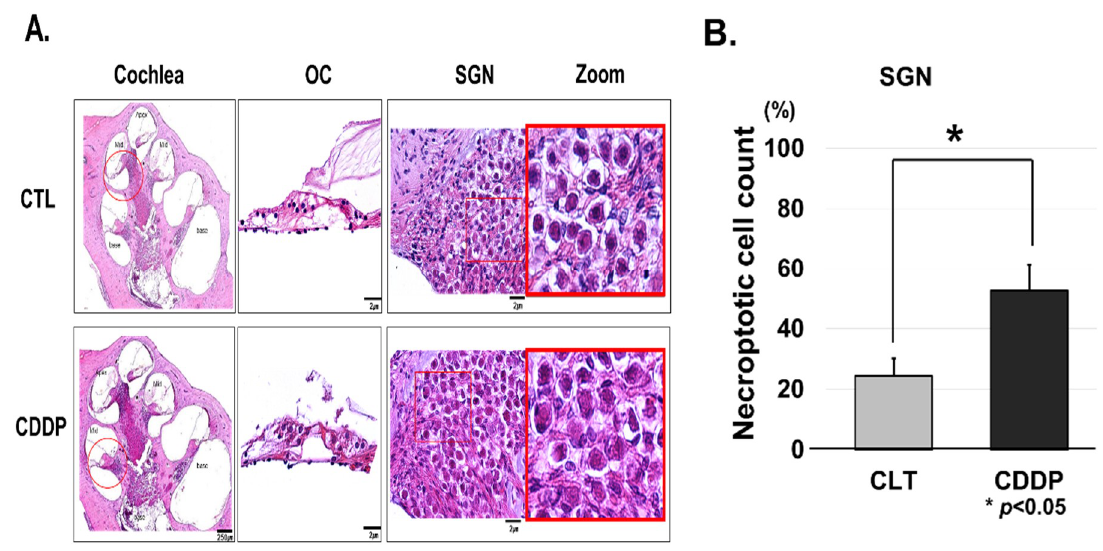
Figure 2. Cisplatin induces OC and SGN injury in vivo. ( A ) Hematoxylin and eosin stain. Necroptotic changes were pronounced in the OCs and SGNs in cisplatin-induced ototoxicity compared to the control. ( B ) Quantitative analysis of necroptotic cell count in SGN region. We counted a number of necroptotic cell in SNG regions. The numbers were counted as to how many of the hundred SGN cells were necroptotic and statistical analysis was performed using ANOVA. Necroptotic cells in CDDP group were significantly counted than those in control. OC, organ of Corti; SGN, spiral ganglion neuron; CTL, control; CDDP, cisplatin; ANOVA, analysis of variance.